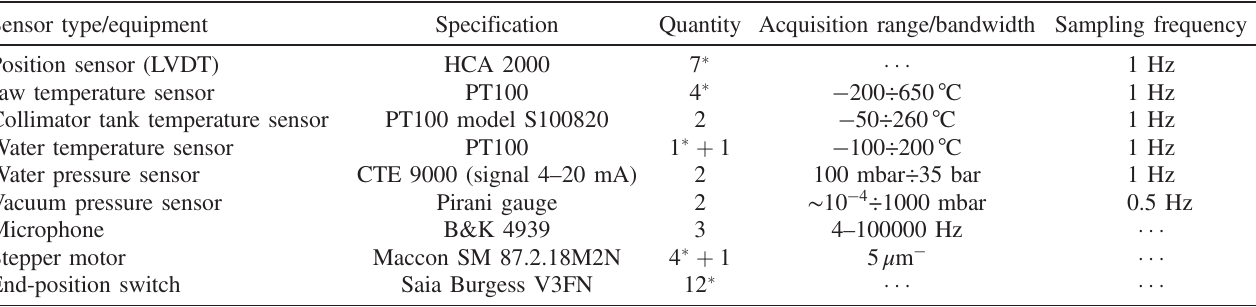
TABLE II. Main characteristics of the digital acquisition system and other equipment used in the experiment. The number of standard LHC collimator equipment is represented by *. The rest is equipment added specifically for the tests.